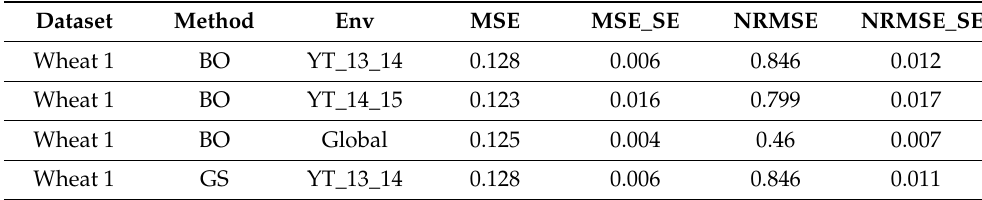
Table A1. Prediction performance for every environment and across environments (Global) of the dataset 1 in terms of mean squared error (MSE), normalized root mean square error (NRMSE) under three methods of tuning (BO, GrS, and NT). MSE_SE and NRMSE_SE denotes the standard errors (SE) under MSE and